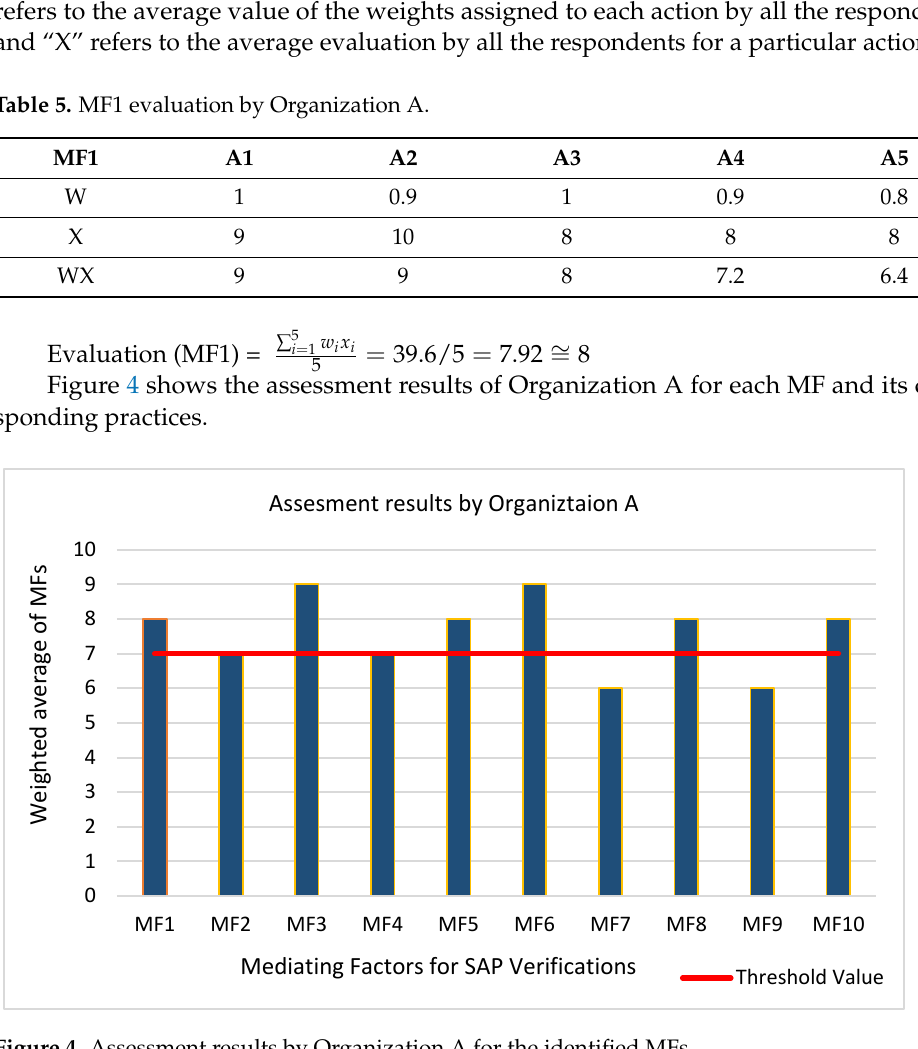
Table 5. MF1 evaluation by Organization A .